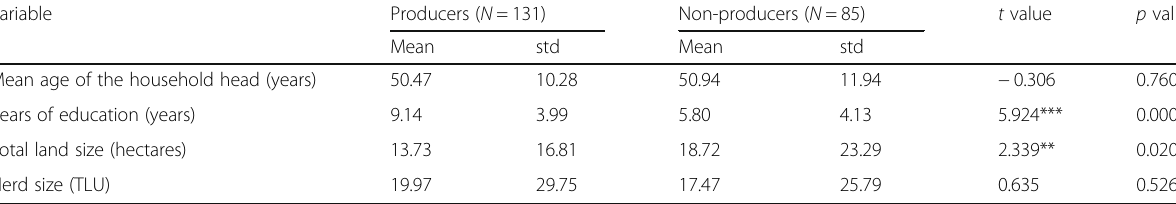
Table 3 Descriptive for the hypothesized variables used in the model Variable